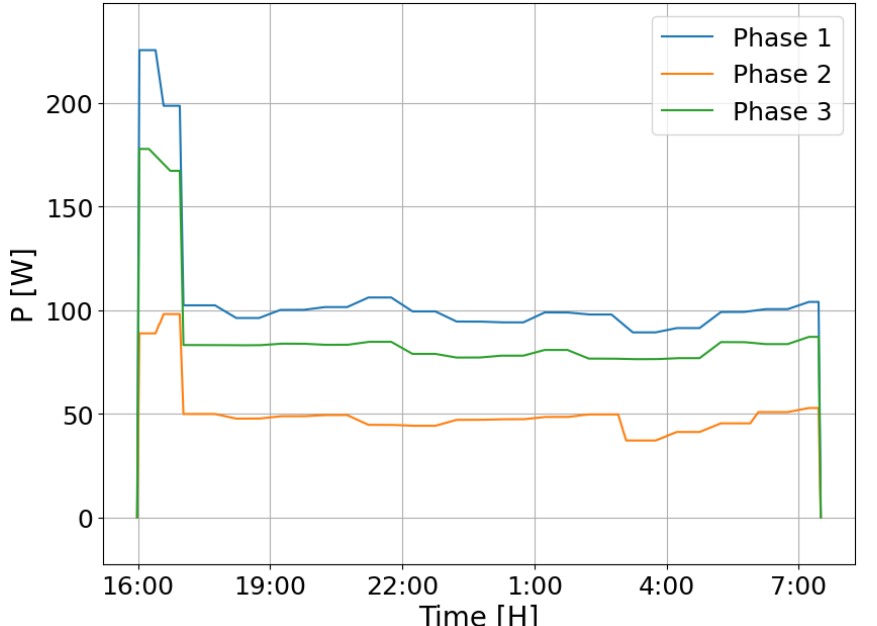
Figure 7. Characteristic of changes in active power values—luminaires with discharge sources (without reduction). Source: own